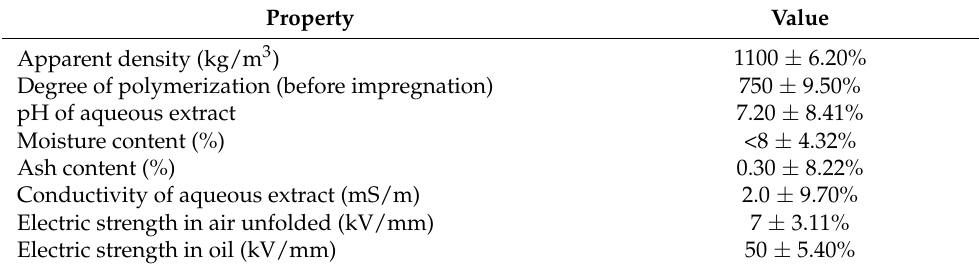
Table 2. PSP 3055 properties.